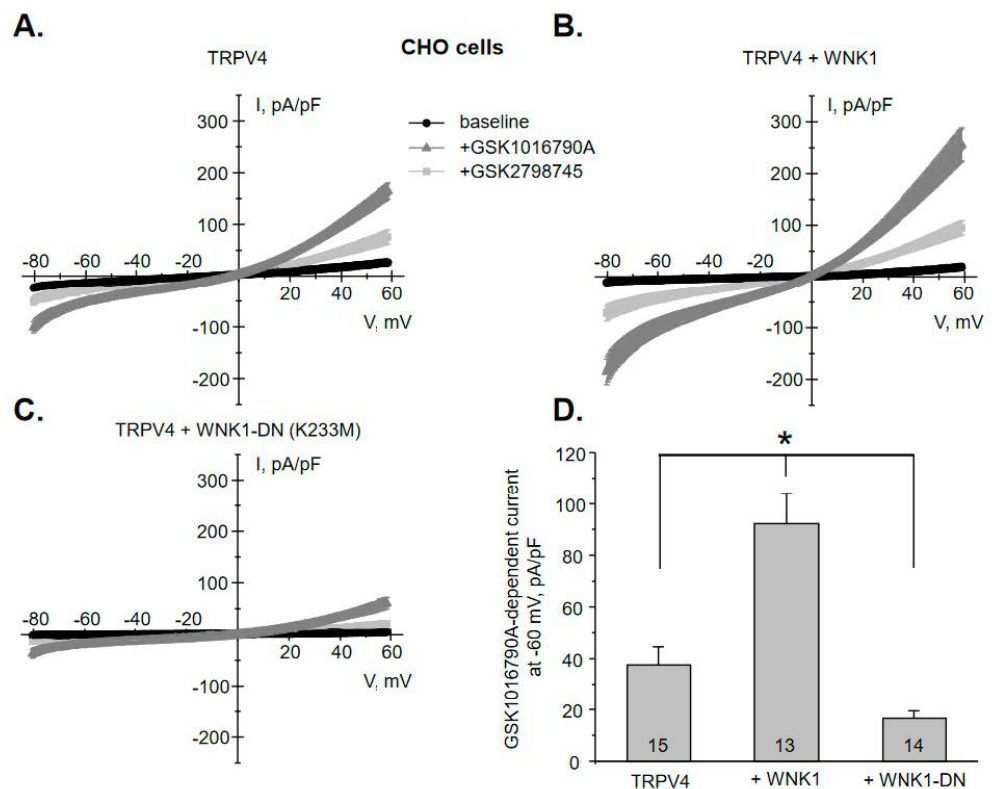
Figure 8. WNK1 regulates TRPV4 activity in a kinase-dependent manner. ( A ) Averaged macroscopic whole-cell current- voltage (I-V) relations in Chinese Hamster Ovary (CHO) cells transfected with TRPV4 at the baseline (black), following application of TRPV4 agonist GSK1016790A (40 nM) for 5 min (gray), and TRPV4 antagonist GSK2798745 (40 nM) for 3 min (light gray). Currents were evoked by a voltage ramp from -80 to +60 mV for 1 sec. The averaged whole-cell I-V relations upon transfection of TRPV4 with WNK1 ( B ) and kinase dead WNK1 dominant negative (DN) point mutation K233M ( C ). All other conditions are identical to those described in panel A. ( D ) The summary graph comparing the amplitudes of GSK1016790A-induced currents at -60 mV for CHO cells transfected with TRPV4, TRPV4 + WNK1, and TRPV4 + WNK1-DN. The number of individual experiments is shown for each condition. *—significant difference ( p < 0.05) between groups is indicated with a line on top.